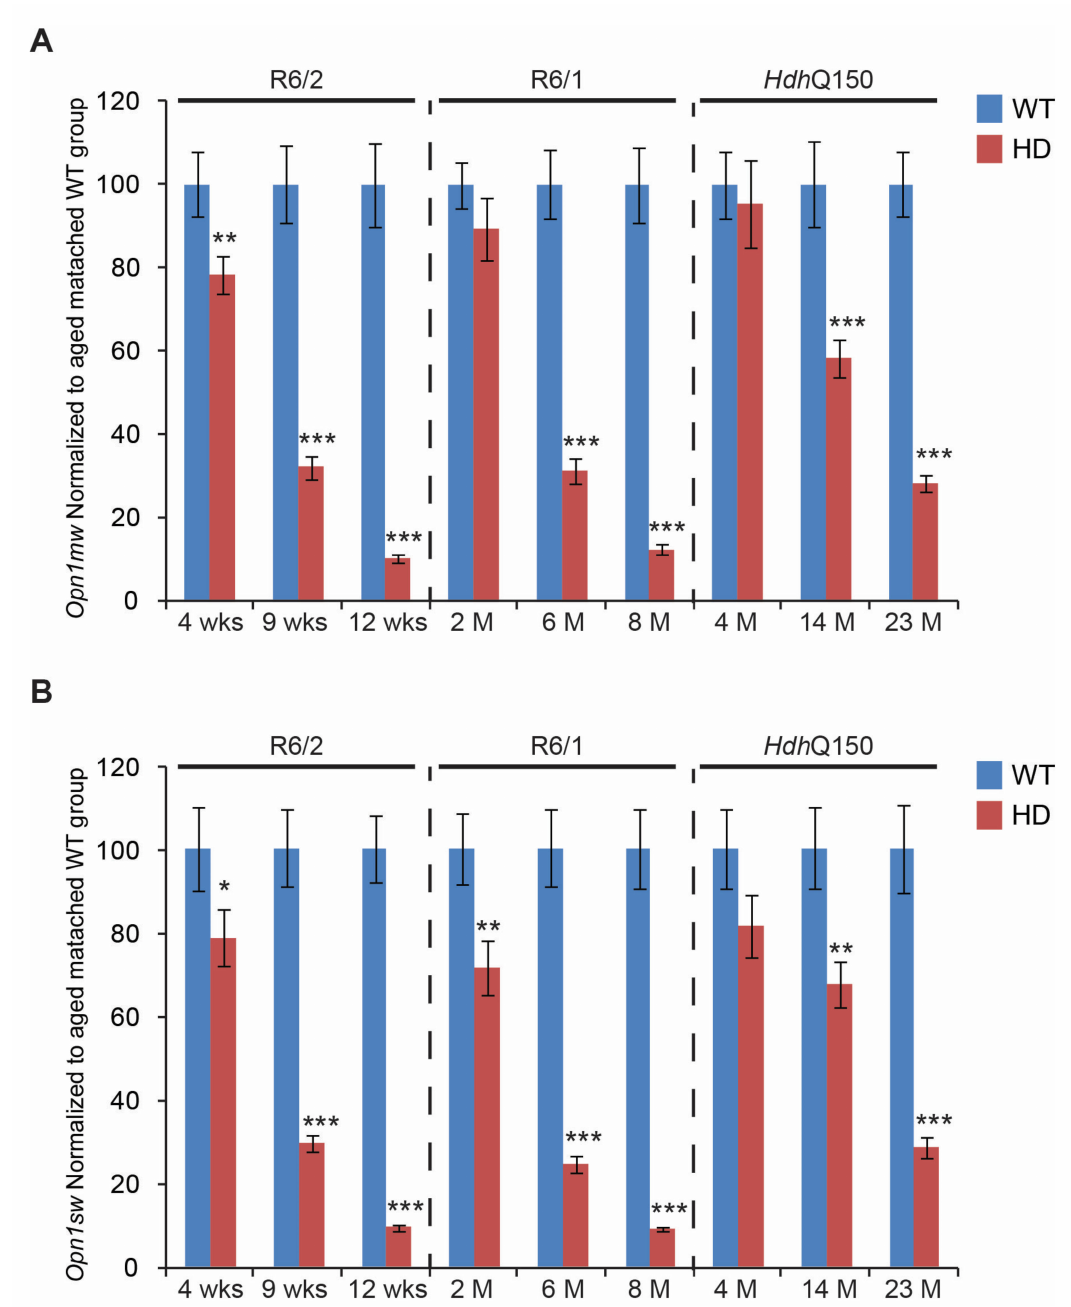
Figure 3. Transcriptional alterations of two Opsin genes involved in normal color vision. Transcripts of ( A ) Opn1mw (Opsin 1: cone pigments, medium-wave-sensitive) , ( B ) Opn1sw (Opsin 1: cone pigments, short-wave-sensitive), were assessed in the eye of three HD mouse models at: pre-symptomatic stage (4 weeks R6/2 mice, 2 months R6/1, mice and 4 months Hdh Q150 mice); symptomatic stage (9 weeks R6/2 mice, 6 months R6/1 mice, and 14 months Hdh Q150 mice), and end-stage (12 weeks R6/2 mice, 8 months R6/1 mice, and 23 months Hdh Q150 mice). All Taqman qPCR values were normalized to the geometric mean of three housekeeping genes, as indicated in the Materials and Methods section. Error bars are ± SEM (n = 6). SEM represents biological replicates. Student’s t -test: * p < 0.05, ** p < 0.01; *** p <